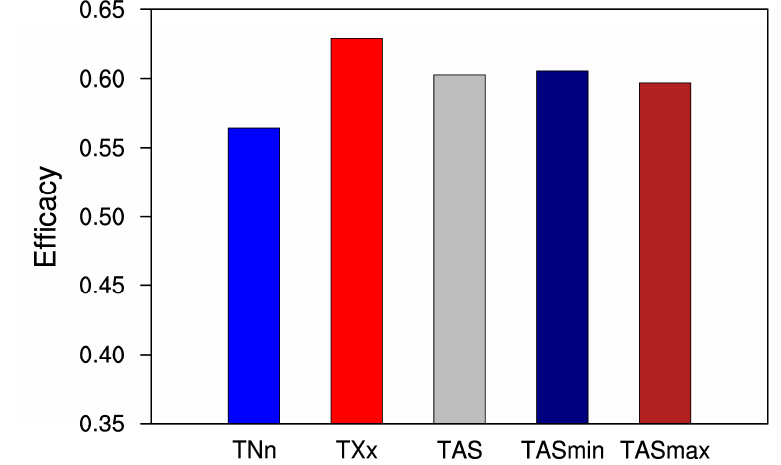
Figure 9. Annual e ffi cacy of the G4cdnc experiment for neutralizing extreme (TNn and TXx) and daily mean (TAS), daily minimum (TASmin), and daily maximum (TASmax) temperatures in RCP4.5 over East Asia. Results are shown for multi‐model ensemble mean.